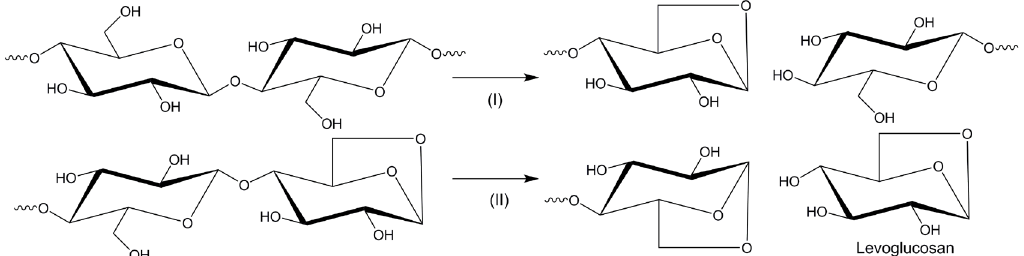
Figure 6. Formation of levoglucosan according to concerted mechanism